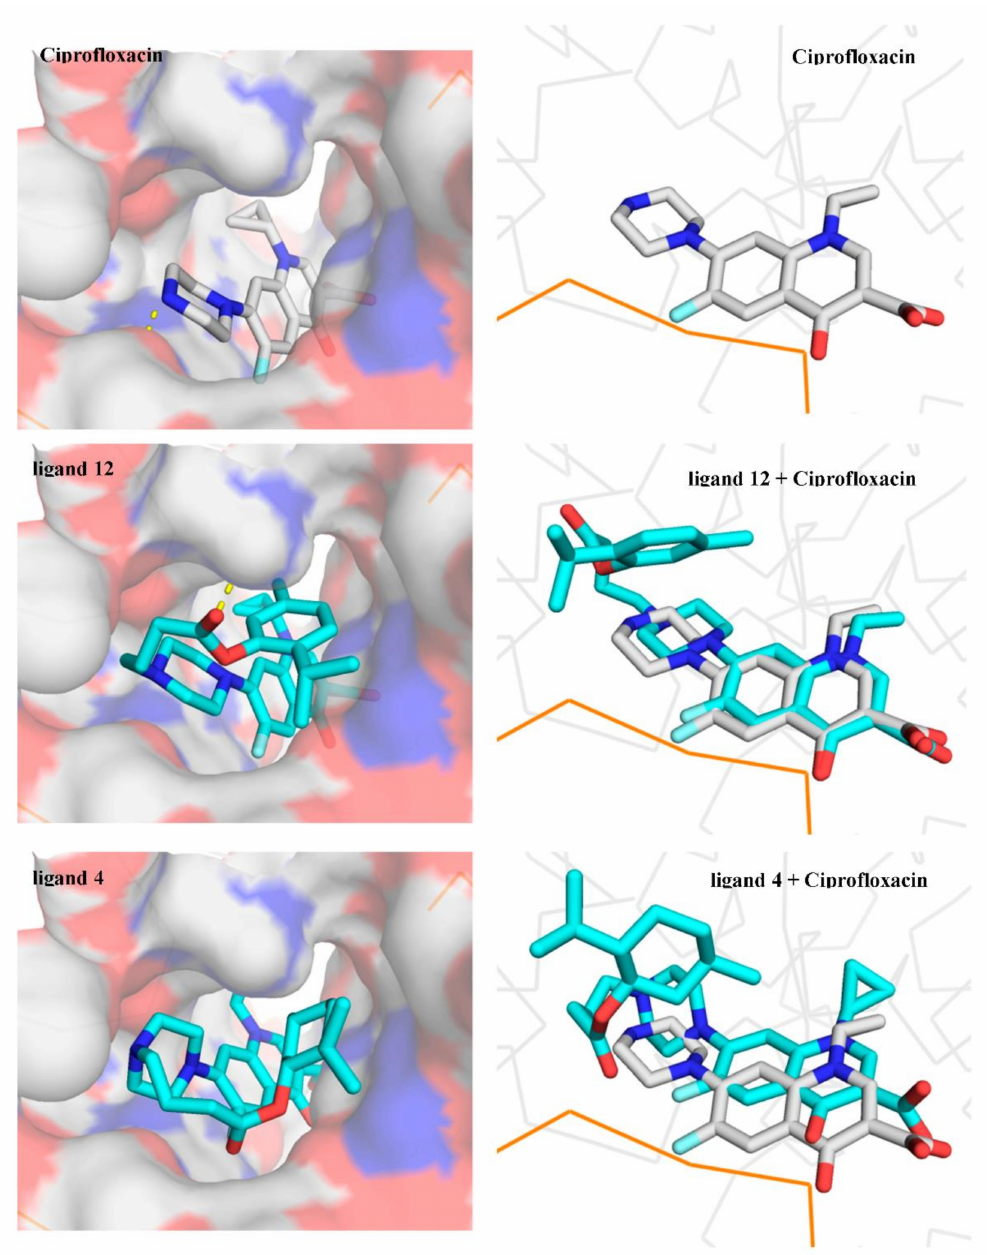
Figure 2. Binding modes obtained in molecular docking for Ciprofloxacin (upper panels) and selected ligands 12 (middle panels) and 4 (lower panels). Left column shows views from the outside of the binding pocket, where the pocket is presented as a surface. Right column shows views from the inside of the pocket that compare ligands positions with the Ciprofloxacin (protein and DNA chains are shown as gray and orange lines, respectively). In addition, polar interactions made by Ciprofloxacin piperazine ring and the carbonyl oxygen of the ligand 12 (from the oxobutyl linker) with the pocket edge have been marked with yellow dashed